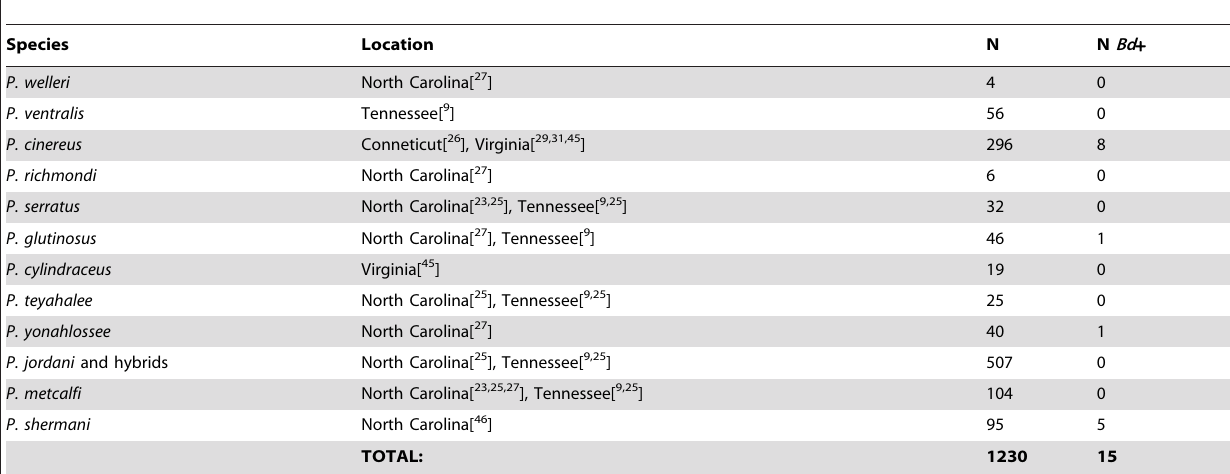
Table 3. Compilation of previous studies that have tested Plethodon salamanders for Bd infection in the eastern US.